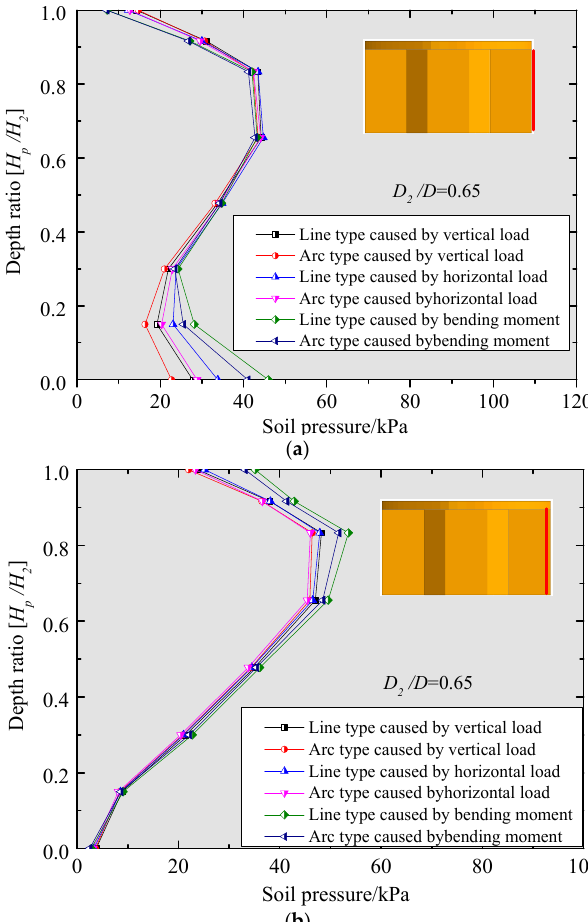
Figure 11. Soil pressures on the front bucket: ( a ) Outside skirt; ( b ) Inside skirt.